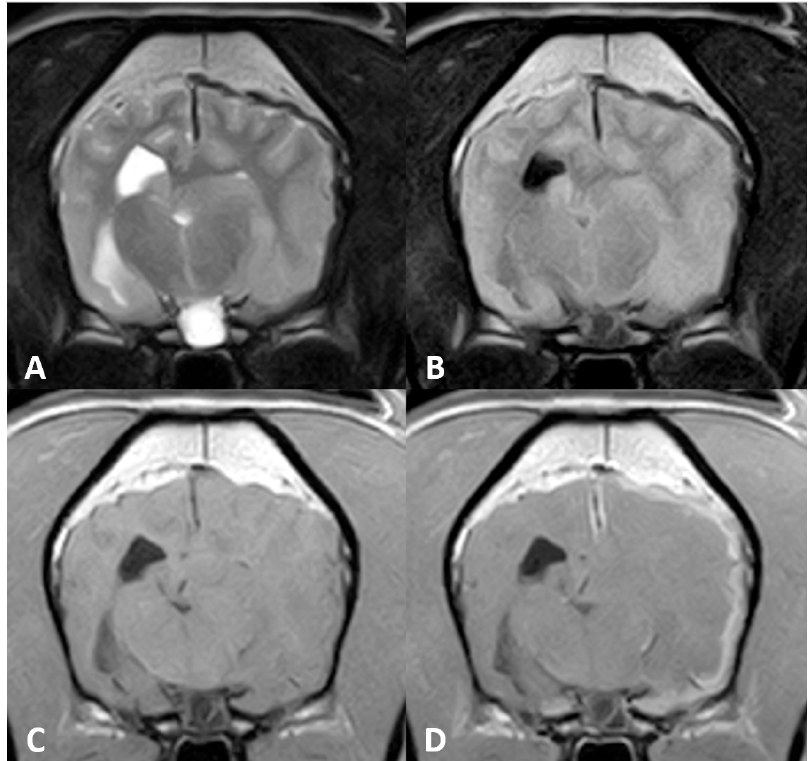
Figure 1. Magnetic resonance (MR) imaging of the brain of Case 1, transverse images at the level of the thalamus. A plaquelike extra-axial mass is visible covering the left hemisphere with ( A ) a marked hypointense signal on T2-weighted (T2w) sequences and ( B ) fluid attenuation inversion recovery (FLAIR). ( C ) T1-weighted (T1w) hyperintensity was not visible, but ( D ) marked enhancement after contrast administration could be detected. Note the severe mass effect and peritumoral oedema causing occlusion of the left lateral ventricle.